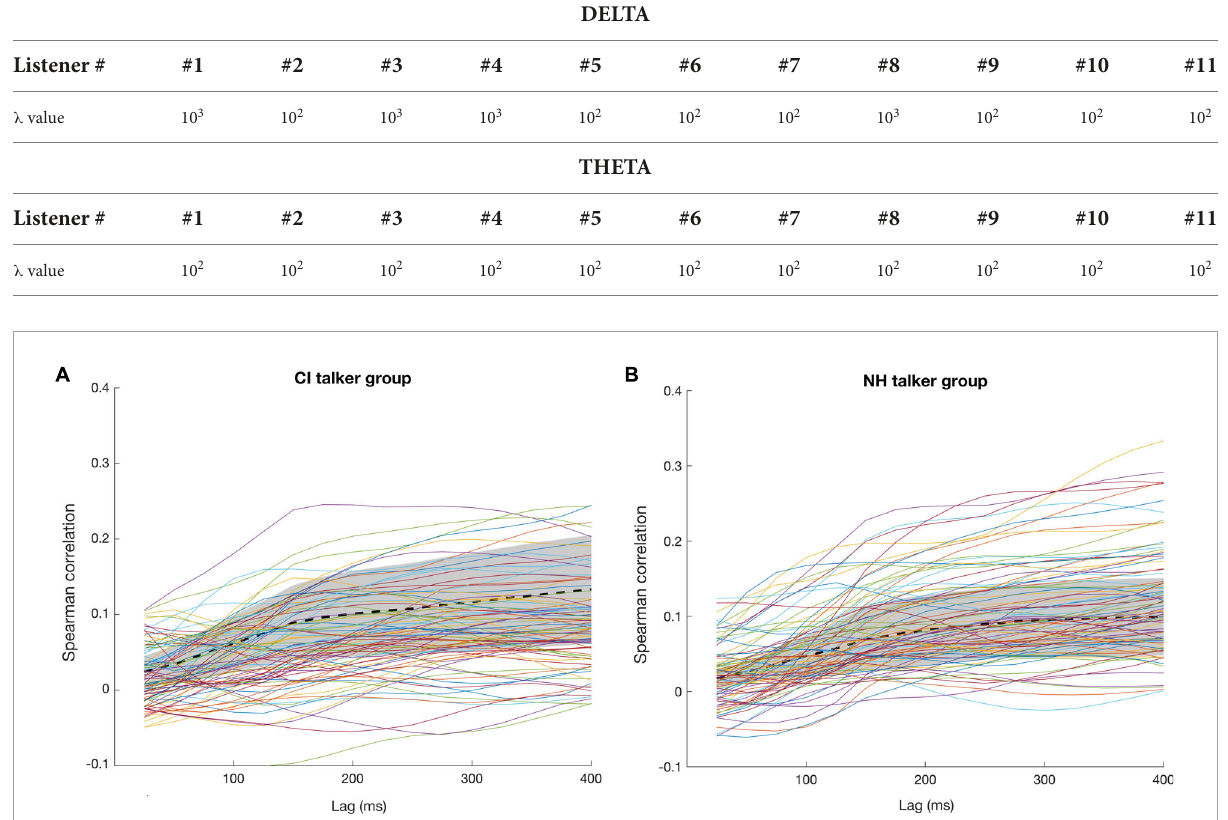
FIGURE8 Spearman correlations between the actual speech envelope and the reconstructed envelope for (A) CI talker group and (B) NH talker group across the time lags. The thick dotted lines represent the mean values, and the shaded areas represent the standard deviation across the